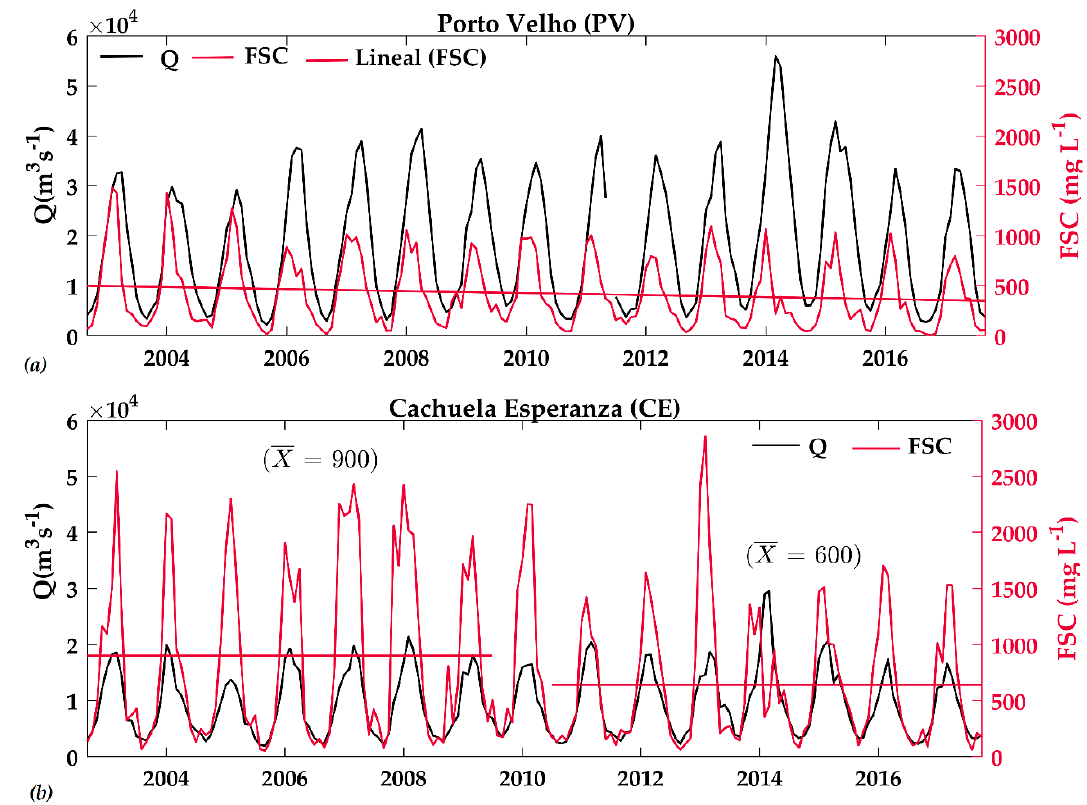
Figure 5. Monthly time series (2003–2017) for Q in m 3 · s − 1 and FSC in mg · L − 1 at ( a ) PV in the Madeira River and ( b ) CE in the Beni River. 𝑥̅ indicates the mean FSC for two periods at CE. The second period, from January to February 2013, was not considered.